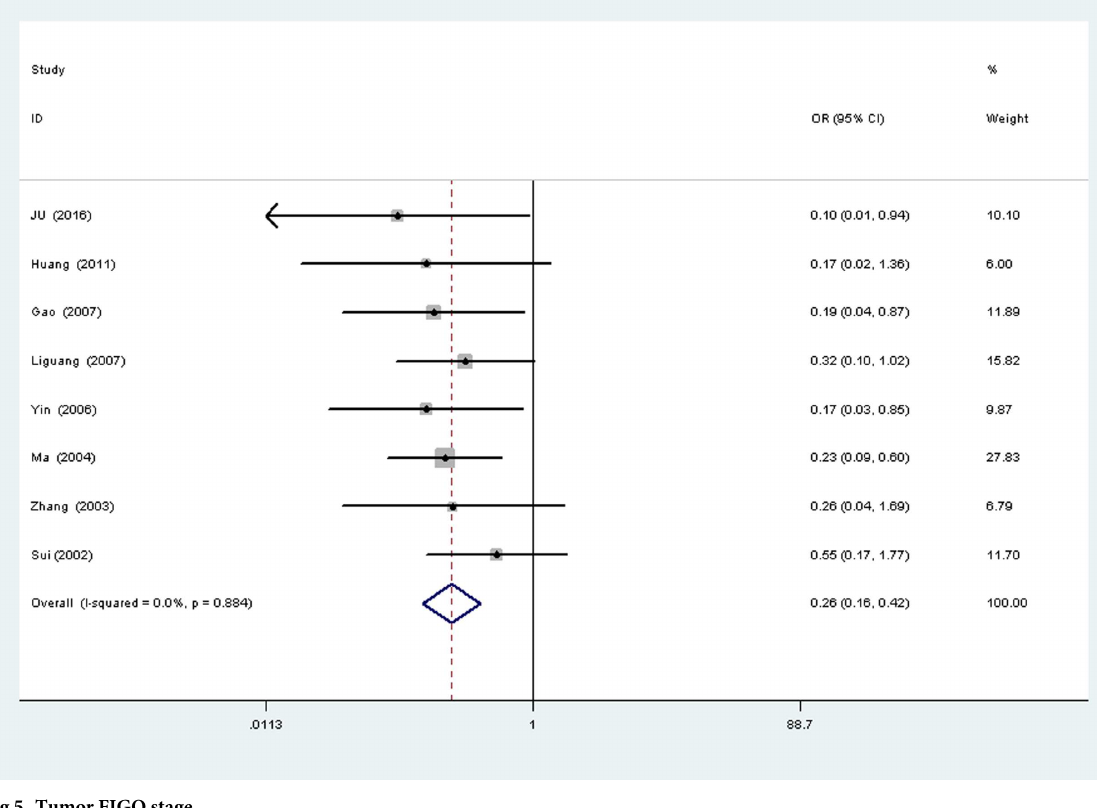
Fig 5. Tumor FIGO